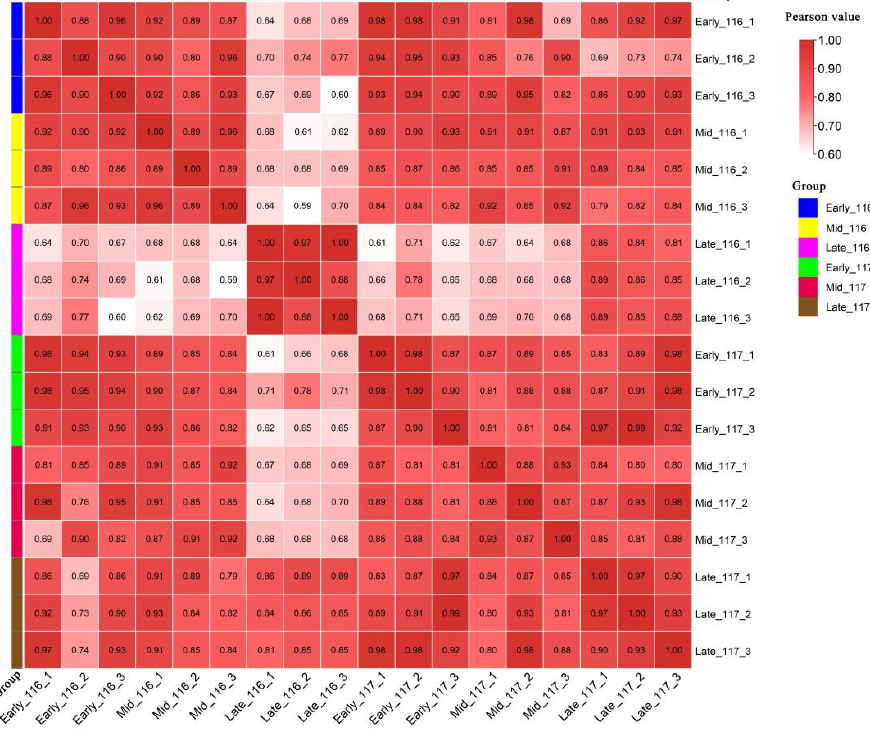
Figure 2. Individual correlation analyses between 18 transcriptome samples.